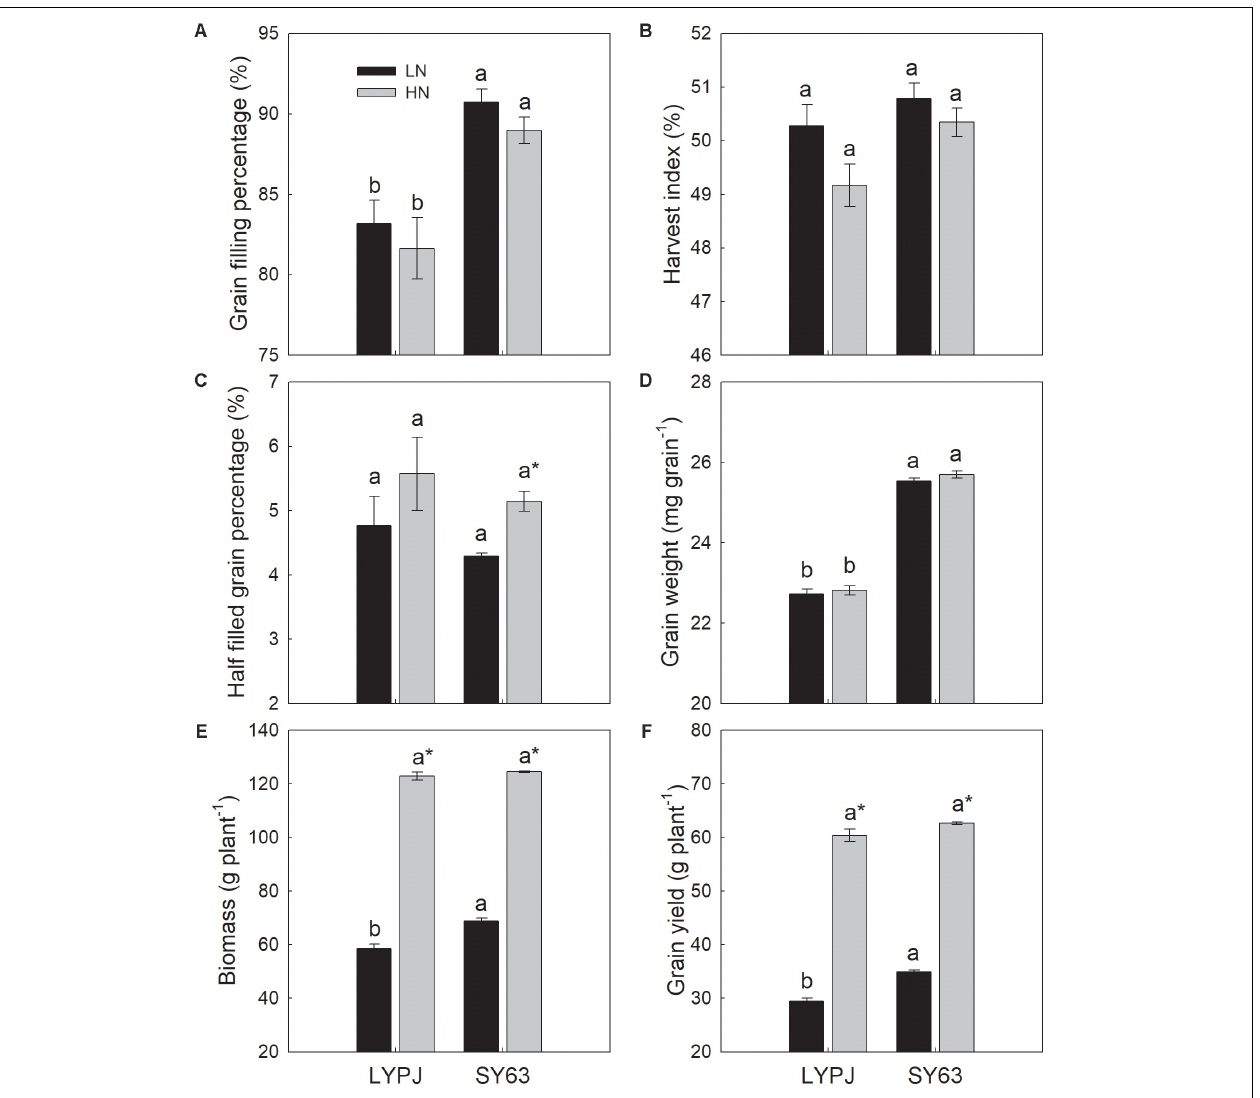
FIGURE 2 | Grain filling percentage (A) , harvest index (B) , half-filled grain percentage (C) , grain weight (D) , biomass (E) , and grain yield (F) of LYPJ and SY63 cultivars under LN and HN treatments. Vertical bars represent the mean ± standard error ( n = 3). Different letters on top of histograms indicate a significant difference at P < 0.05 between the two cultivars under the same nitrogen condition. ∗ Indicates a significant difference at P < 0.05 between the LN and HN treatments for the same